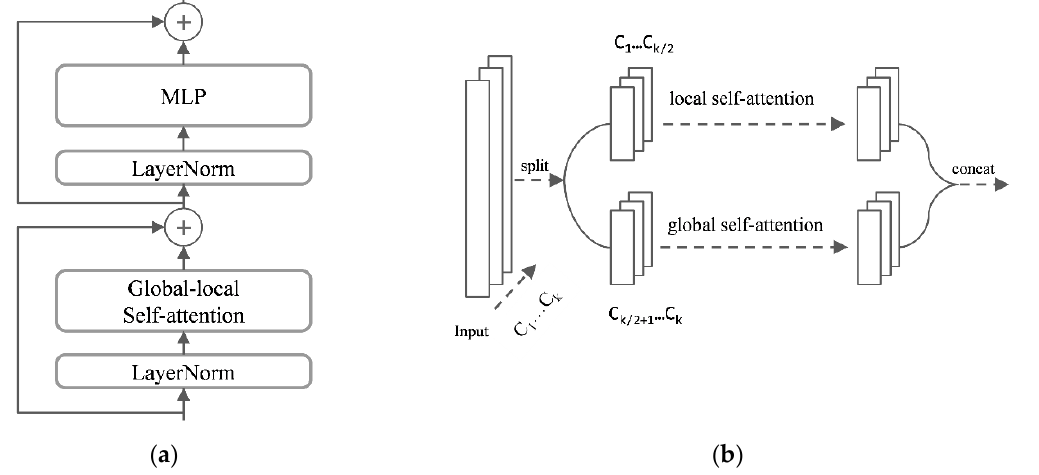
Figure 2. ( a ) The illustration of our proposed Transformer block; ( b ) the illustration of the global–local self-attention.